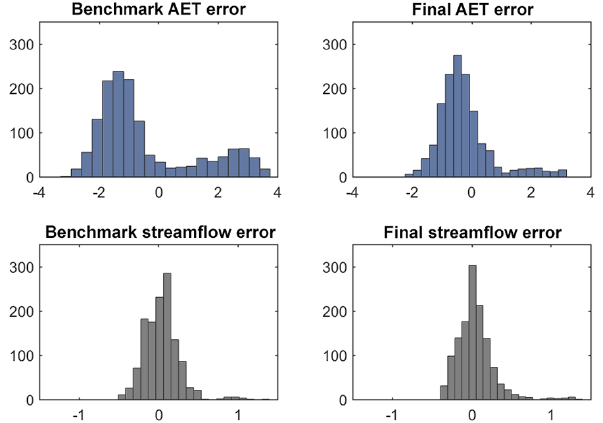
Figure 11. AET and streamflow error distributions for the bench- mark and the final